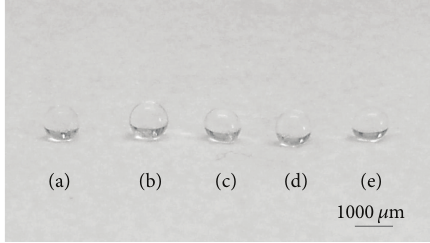
Figure 2: Images of Ca/Co alginate beads with encapsulated hADSCs on day 21 in culture. (a) Control sample; (b) Co1.25 sample; (c) Co2.5 sample; (d), Co5 sample; and (e) Co10